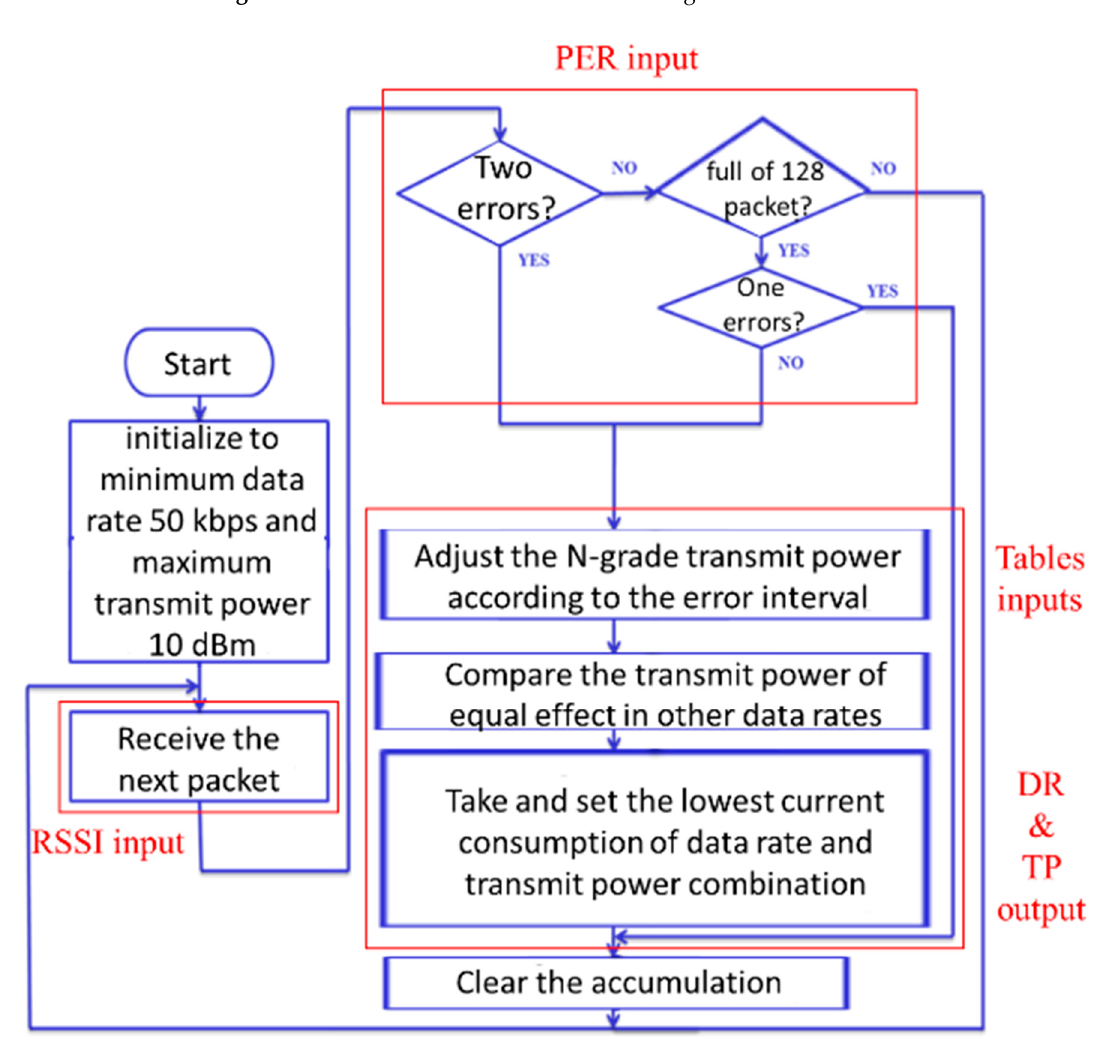
Figure 10. Flowchart of error interval algorithm controlling data rate and transmission power.